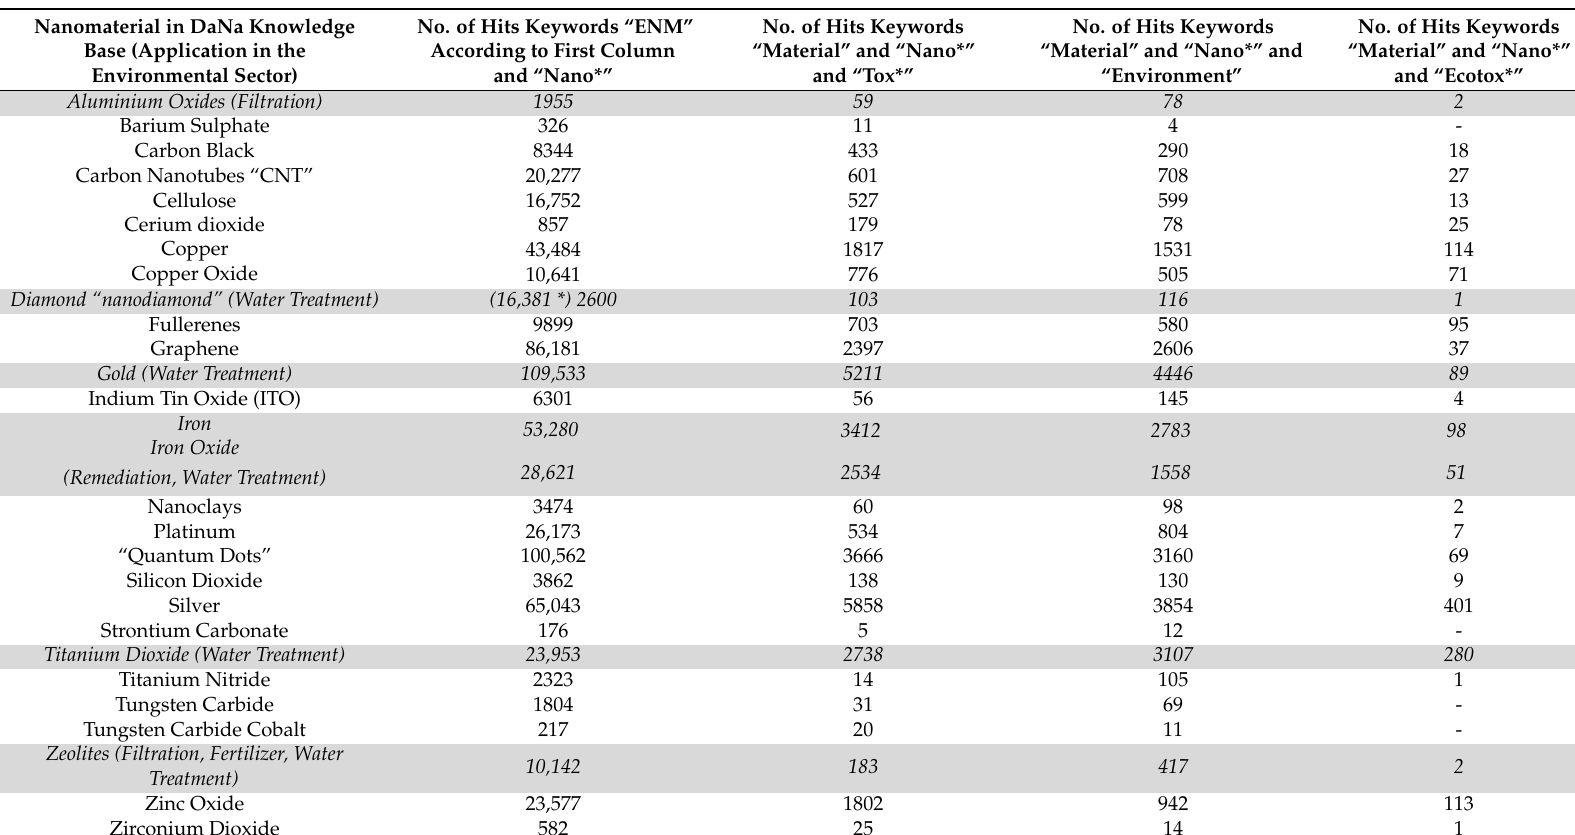
Table 1. Overview of the 26 different ENMs included in the DaNa knowledge base. The number of publications as retrieved in ISI Thomson Reuters Web of Science using the keywords “material” and “nano*” and either “environment”, “tox*” or “ecotox*” are shown. if those search terms did not deliver meaningful results, more specific ones were used as indicated in the respective box (accessed 17 November 2017). The number of publications is informative, because the publications were not filtered any further and may contain accidental hits. ENM in italics mark those with known applications according to the DaNa knowledge base (https://www.nanopartikel.info/en/nanoinfo/knowledge-base) in the environmental sector as specified in brackets. Materials are listed